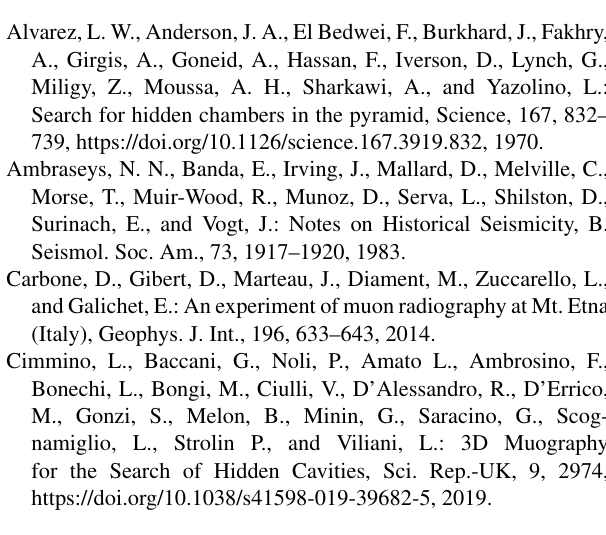
Figure 6. Azimuthal distribution of the relative muon flux for var- ious elevation angles. The solid curves indicate the expected hor- izontal muon flux variations. The relative muon flux values were multiplied for better